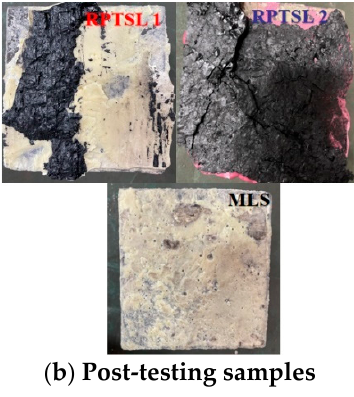
Figure 12. Bonding test result.